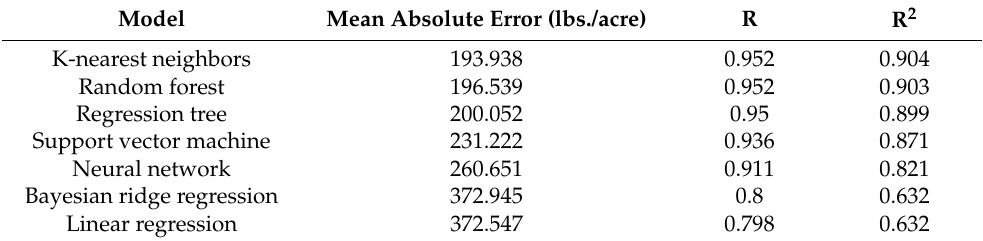
Figure 5. Results from Cfs feature selection with no percent cover. The results from linear regression and Bayesian ridge regression were too low to show. The results are shown explicitly in Table 5. Table 5. Results from Cfs feature selection with no percent cover. The average scores from using the features Julian day, number of days since the sown date, total solar radiation, and total